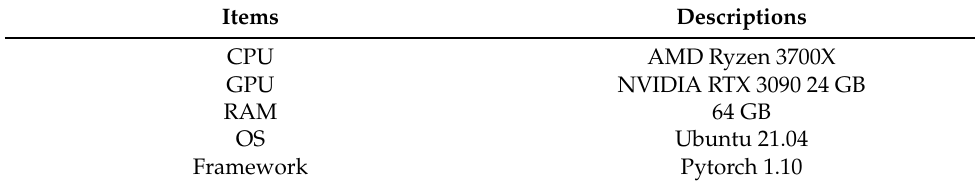
Table 1. Hardware and software